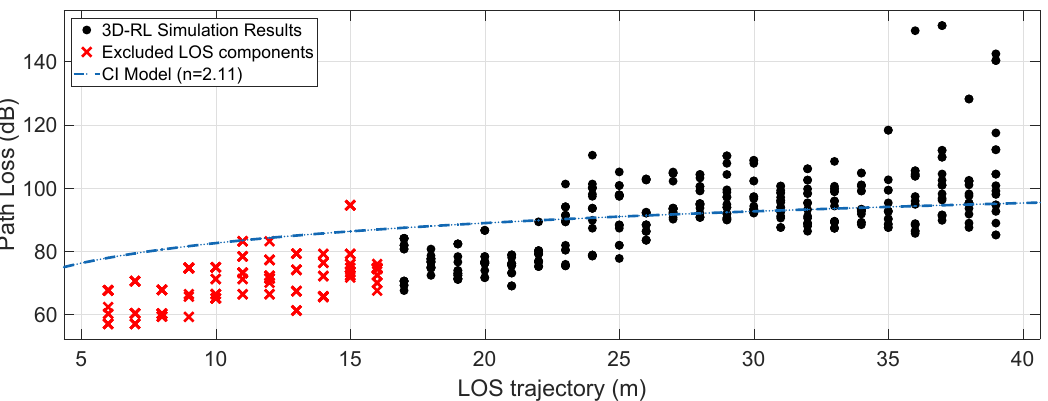
Figure 12. Path Loss (dB) with a car obstruction in a 17-degree area (PLA) and the mean PLE estimation for a CI free-space model.